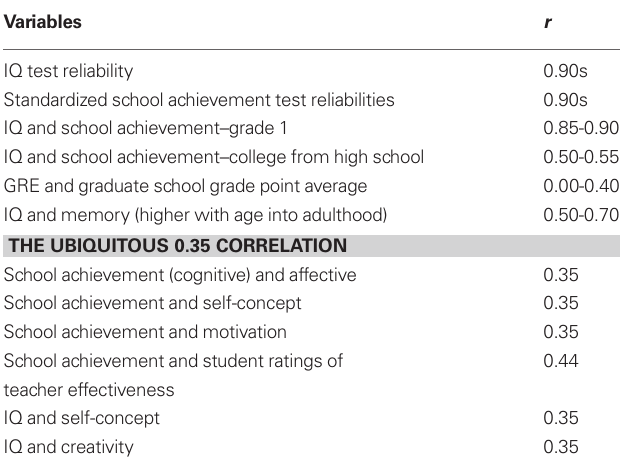
Table 3 | Real-world correlations (excerpt from Follman, 1984, p. 702; the references are